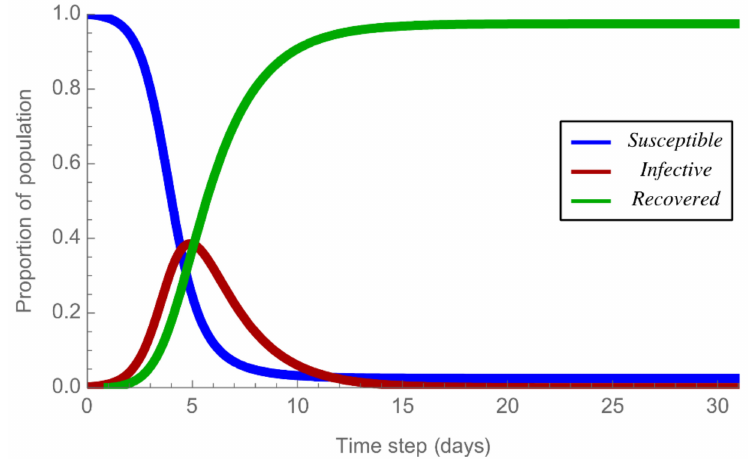
Figure 4. Time series analysis of an epidemic population of susceptible, infective, and recovered nodes. This example depicts the change of the susceptible, infective, and recovered proportion in a population with time as extracted from simulations with a scale-free network with k = 5 and infectious disease parameters β = 0.35 and γ = 1. Initially, a majority of the population is susceptible, whereas the remaining few are infective nodes. During the epidemic, infective nodes transmit their disease to susceptible nodes, and some of the infective nodes recover. Every infective node will recover after about γ d steps. Eventually, two major compartments remain, that is, susceptible nodes and recovered nodes, without any infective nodes. No additional infective nodes are included because there are no infective nodes to transmit the disease. The recovered population includes both the immune living population and individuals who have died of the disease. Accordingly, the final steady state of the green curve indicates the total number of casualties. The fatality rate determines the ratio of the final population of deceased or recovered individuals. We assume that the fatality rate is 100% for the worst-case scenario, that is, extinction.